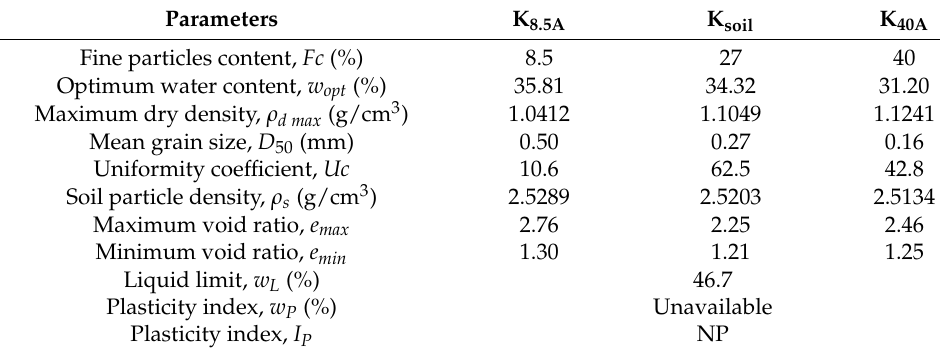
Table 2. Physical properties of test samples in this study.